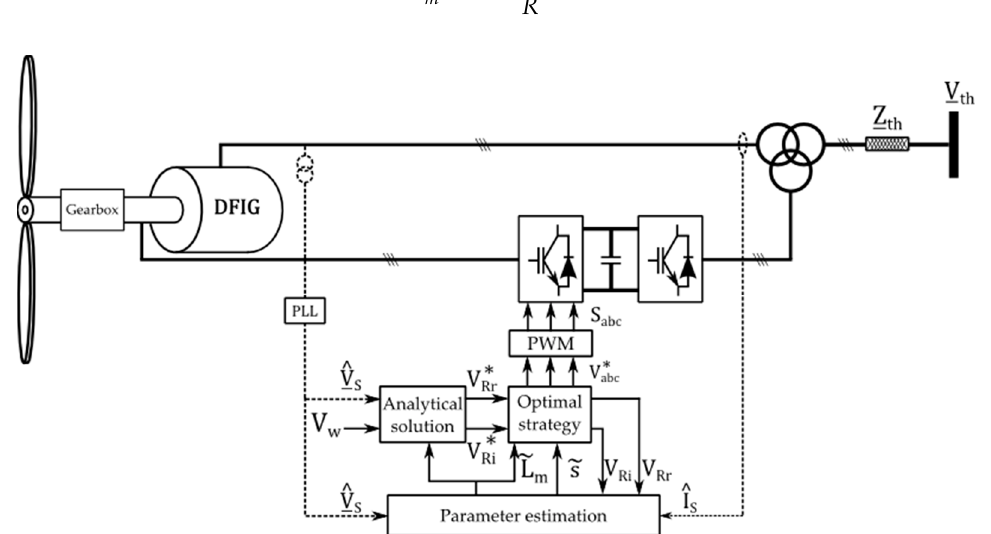
Figure 1. Proposed control and grid simulation topology.